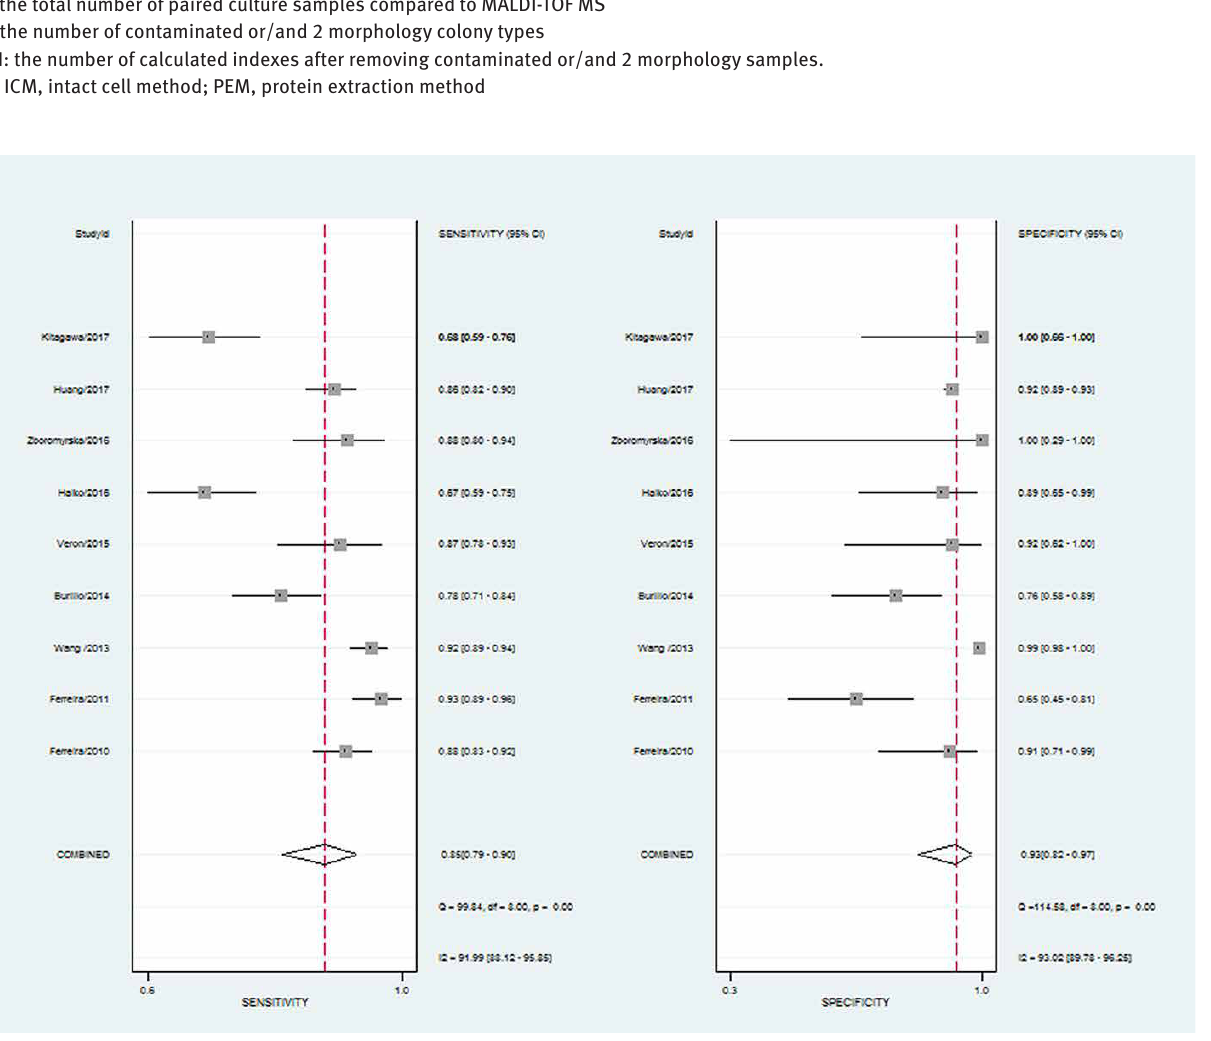
Figure 2: Forest plot of the pooled sensitivity and specificity of MALDI-TOF MS for identifying